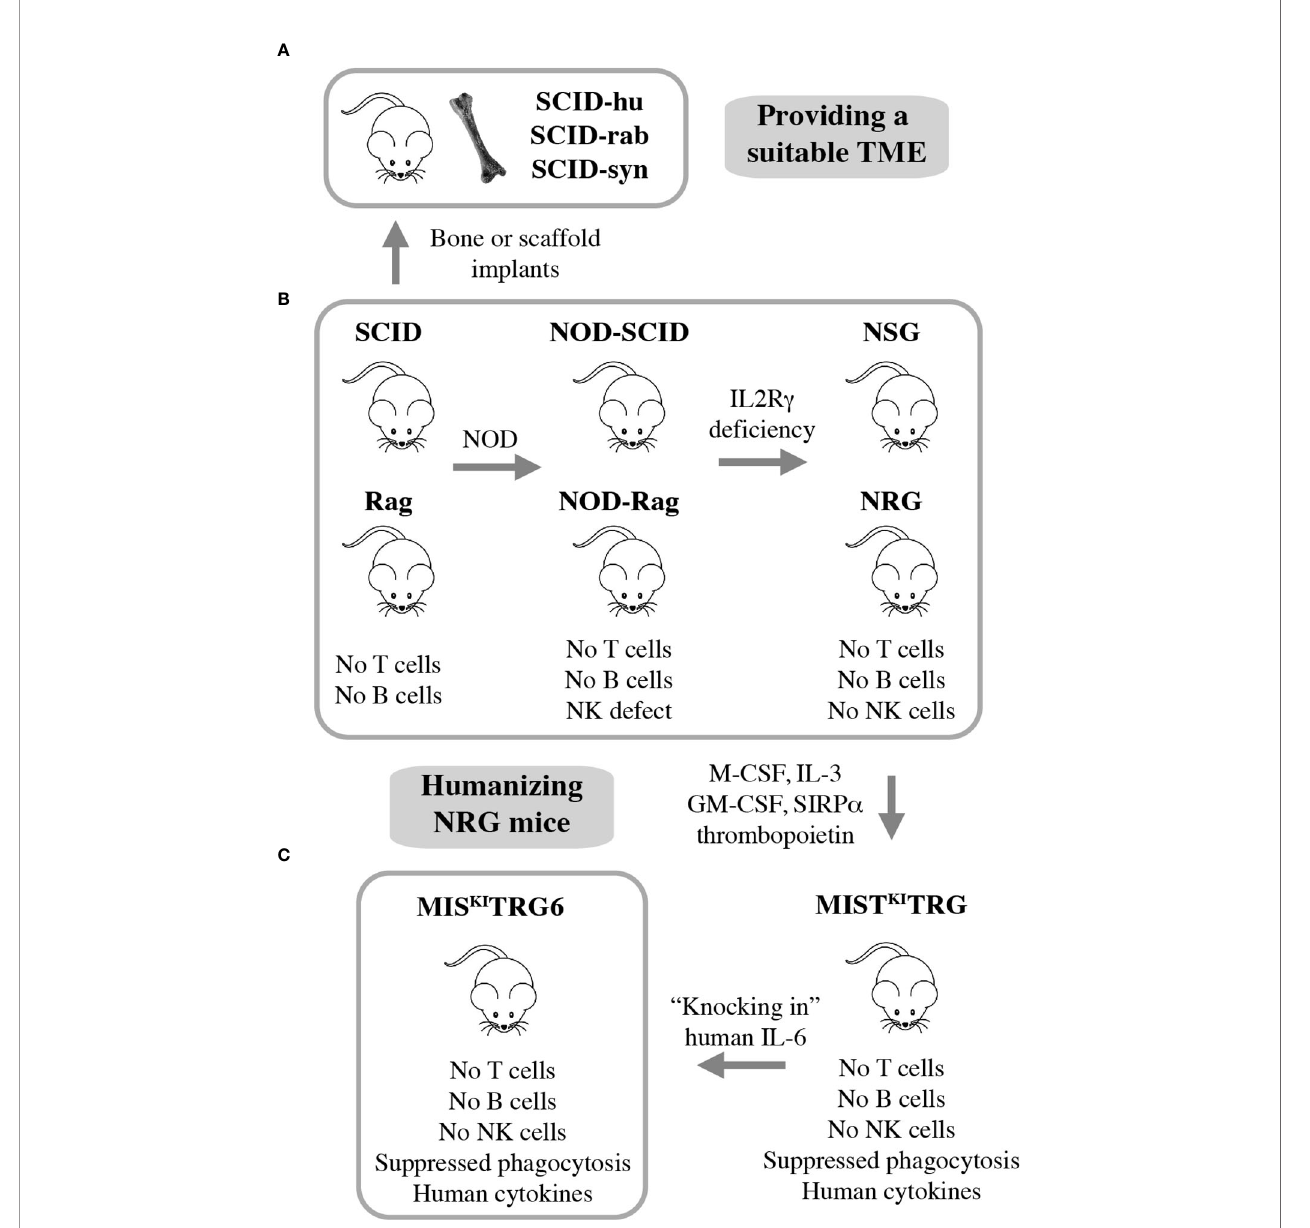
FIGURE 3 | Xenografting human myeloma in immunode fi cient mice. NSG and NRG mice are widely employed for preclinical studies using human myeloma cell lines (HMCLs) but are limited in terms of hosting primary, patient-derived myeloma cells (B) . Implantation of bone chips or arti fi cial scaffolds in SCID mice can overcome this limitation (A) but is faced with practical limitations and the inability to support MGUS and SMM plasma cells. Additional incremental steps in humanizing NSG and NRG mice may solve this problem. A promising step in this direction is the recent development of IL-6 transgenic MIS KI TRG mice, which can support homing and survival of plasma cells not only from patients with frank and smoldering MM but also individuals with MGUS (C)